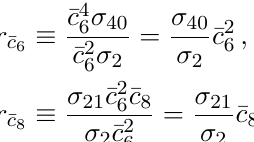
(right) for ZHH and WBF HH 8